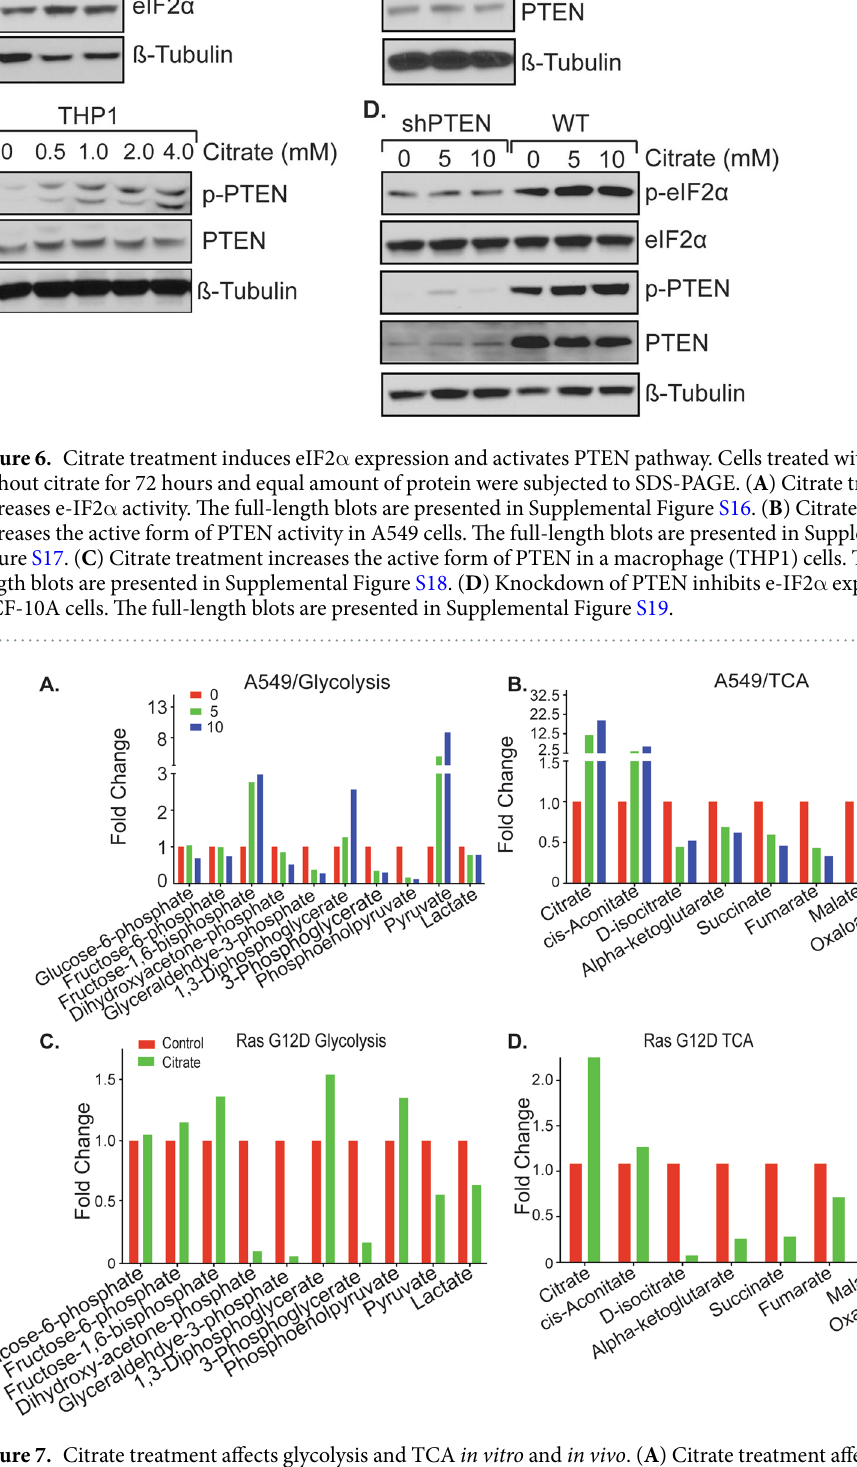
Figure 7. Citrate treatment affects glycolysis and TCA in vitro and in vivo . ( A ) Citrate treatment affects glycolysis in A549 cells. ( B ) Citrate treatment affects the TCA cycle in A549 cells. ( C ) Citrate treatment affects glycolysis in Ras G12D mouse lung. ( D ) Citrate treatment affects the TCA cycle in Ras G12D mouse